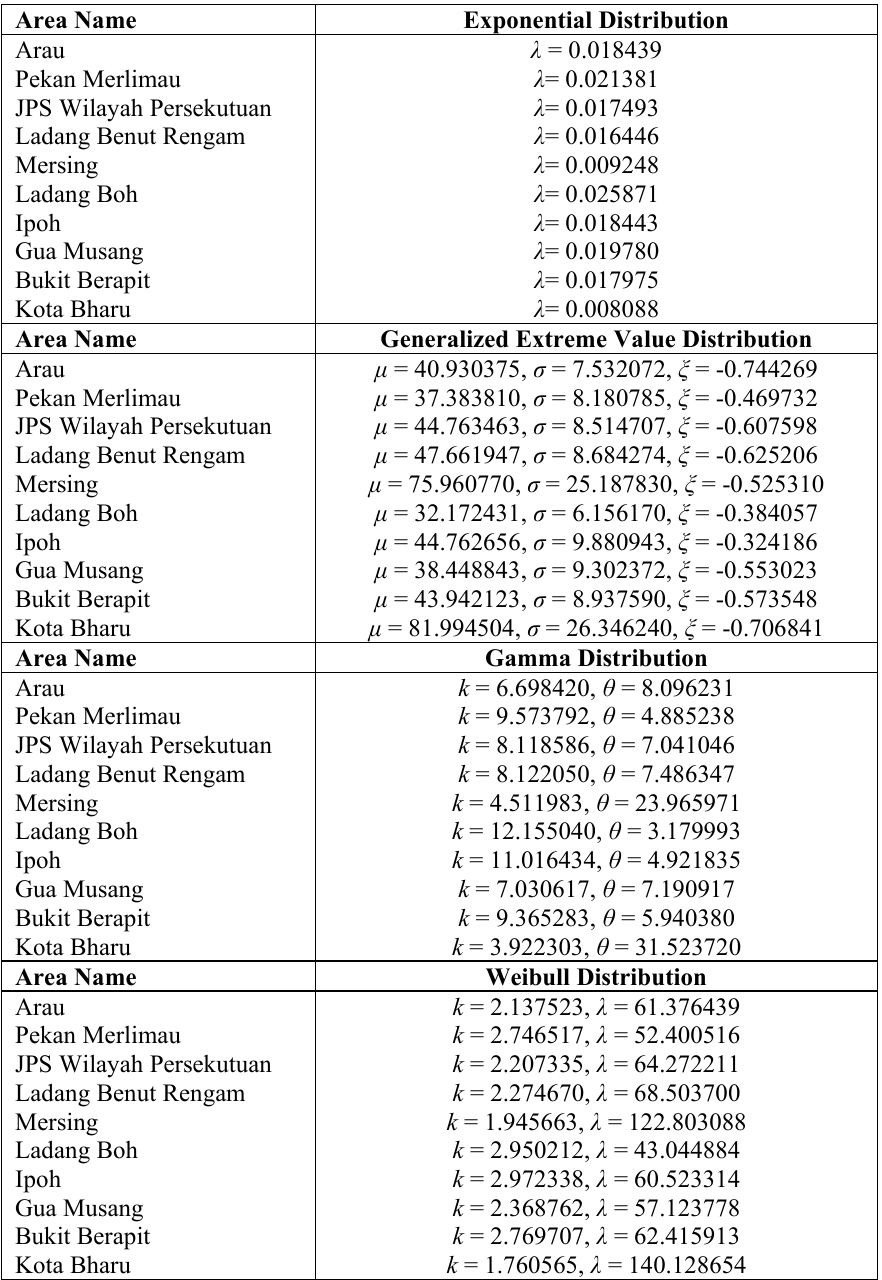
Table 2. Estimated parameters for the threshold value of the 90 th